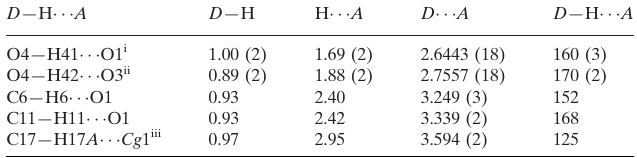
Hydrogen-bond geometry (A˚ , (cid:2) ). Cg 1 is the centroid of the C2–C7